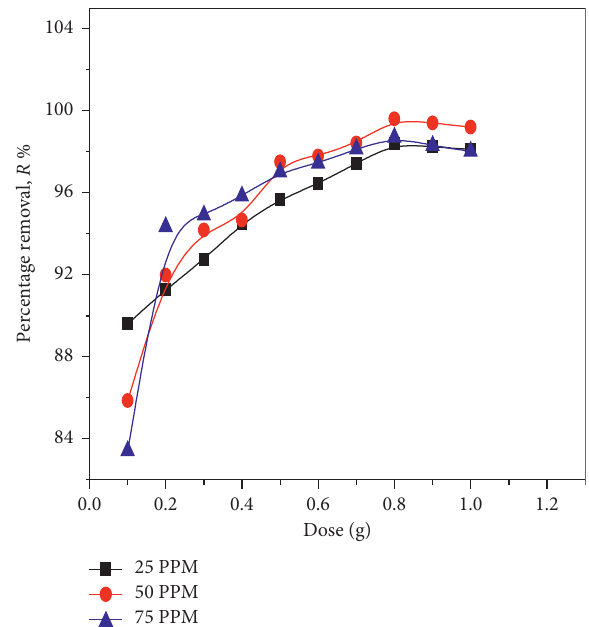
Figure 4: Effect of adsorbent dosage on the adsorption of the BG dye using